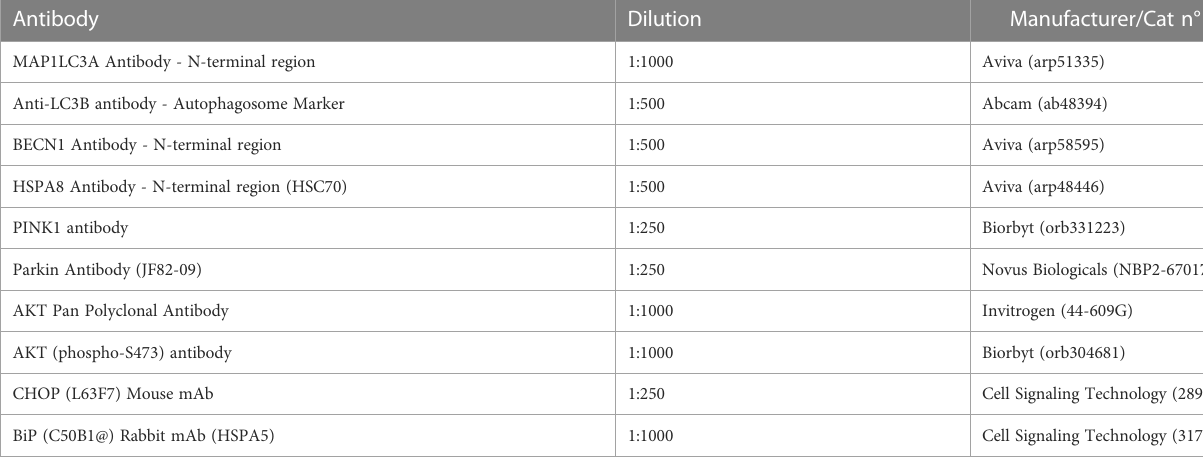
TABLE 3 List of the antibodies and their dilutions used for this study.